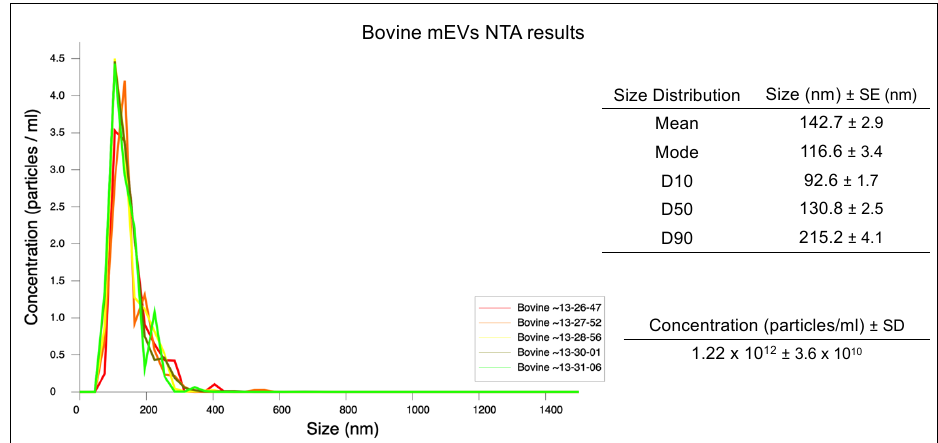
Figure 2. NTA result of mEVs isolated from bovine milk. The peak of the mEV size distribution was 105 nm.